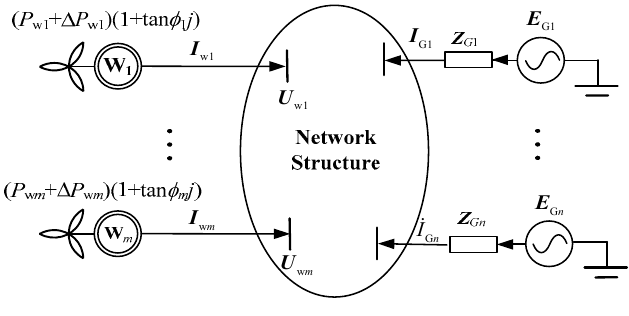
Figure 1. Power system with DFIGs integration.